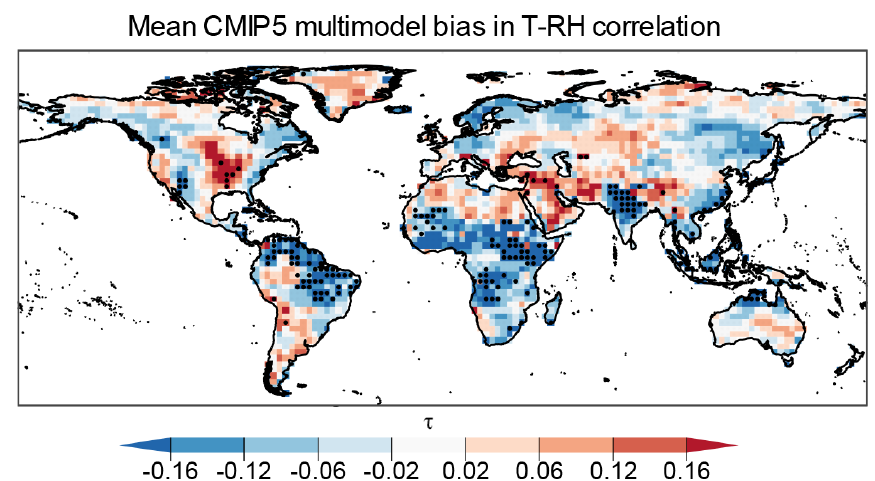
Figure A4. As Fig. 4b but where stippling indicates locations where more than 75% of CMIP5 model sample values lie outside the 95% confidence interval for ERA-Interim.